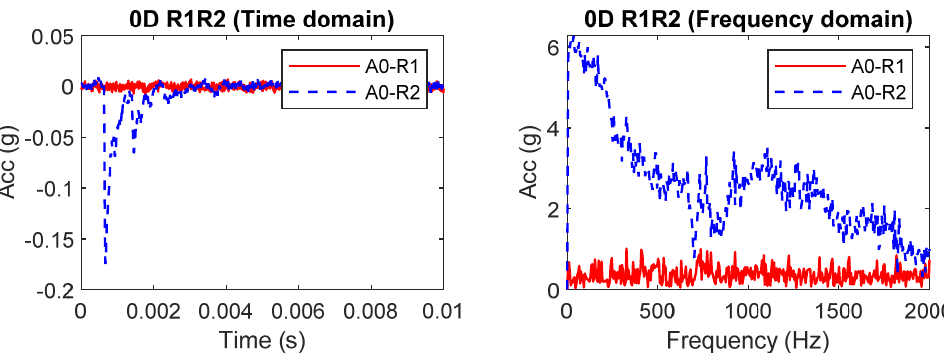
Figure 23. Captured time domain acceleration data and their frequency spectra at A0R1 and A0R2 for Unserviceable Pole 1.